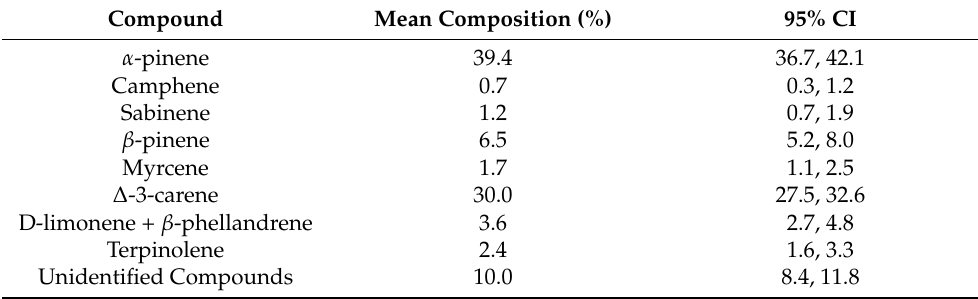
Figure 1. Percent composition of monoterpenes within 56 Larix laricina (Du Roi) K Koch trees throughout Minnesota and Wisconsin collected from 15–16 July 2021. The x on each box represents the mean; the midlines represent the median; and the whiskers represent the interquartile range. Table 2. Population estimates of mean percent compositions of various monoterpenes within 56 Larix laricina (Du Roi) K Koch sampled from Minnesota and Wisconsin, 15 – 16 July 2021, with 95% CI.